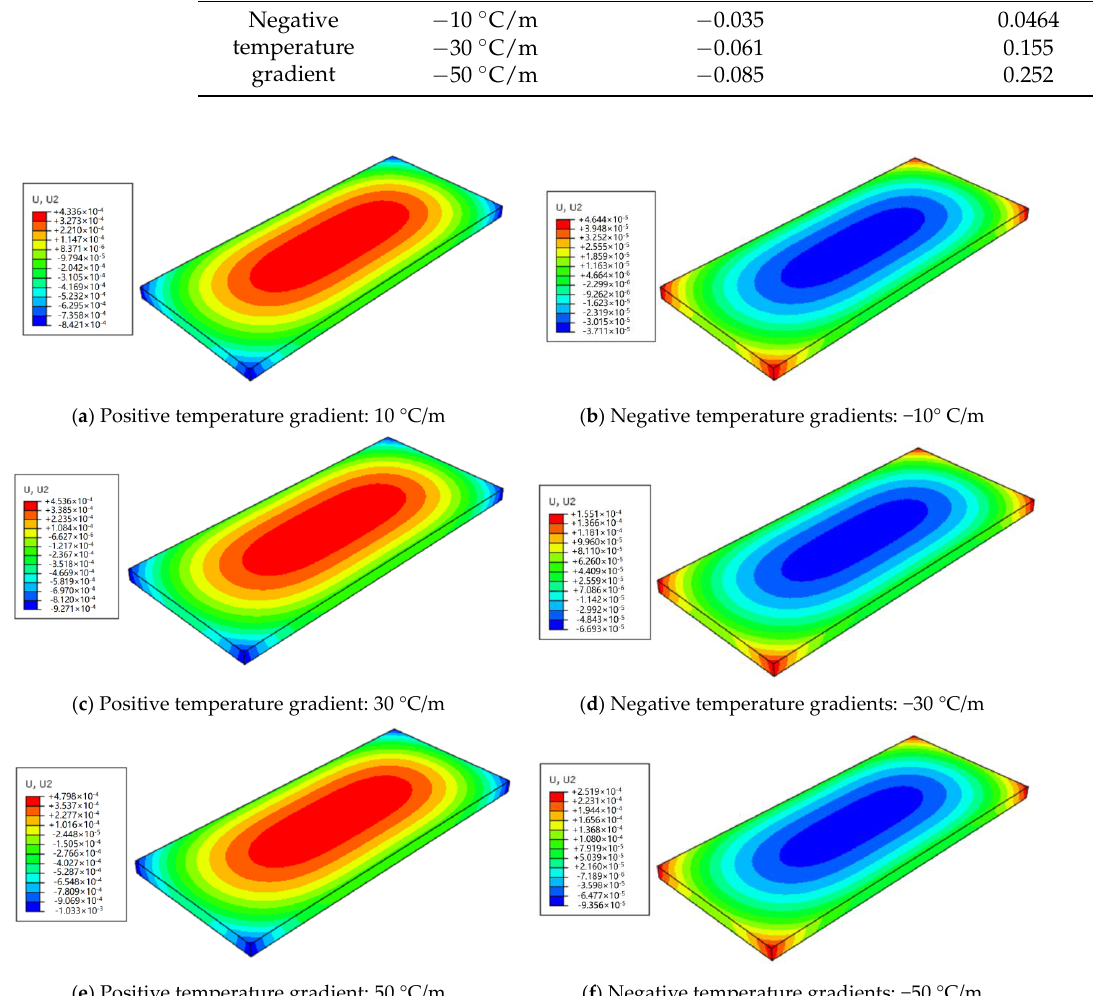
Figure 9. Simulation results of vertical displacement of slab track under positive and negative temperature gradients.